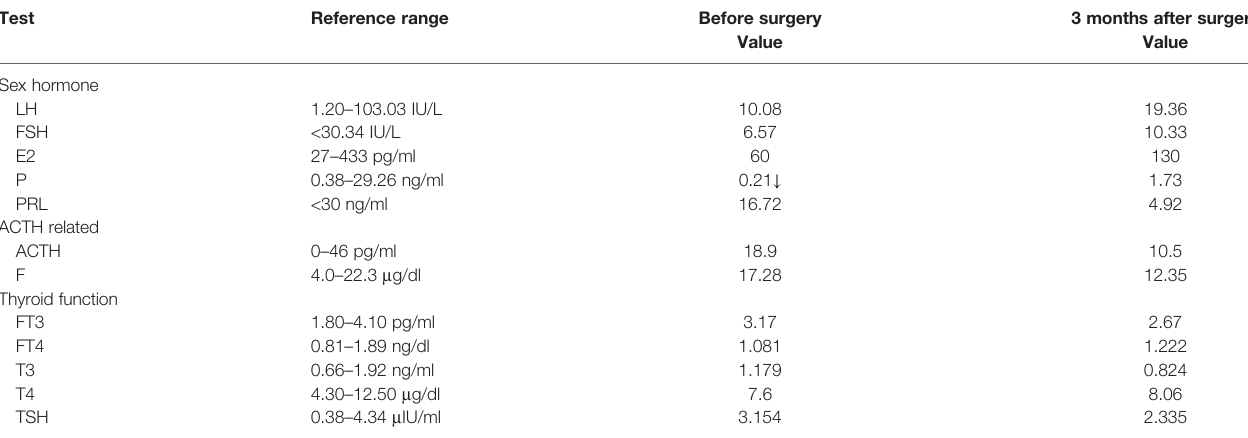
TABLE 1 | Results of endocrine examinations before and after